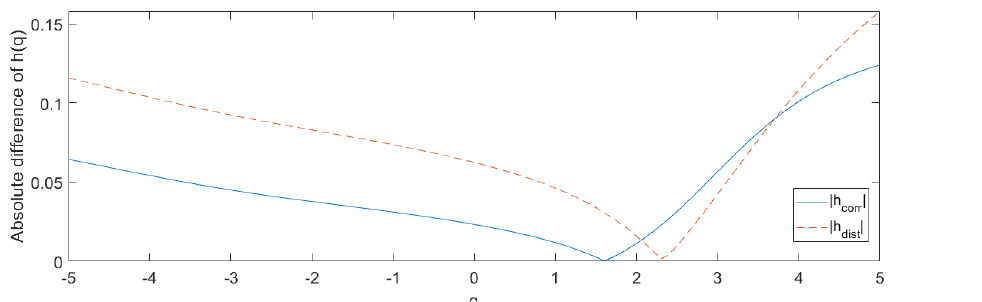
Figure 9. Absolute differences between the generalized Hurst exponents of original and shuffled series, | h corr ( q ) | , and between the generalized Hurst exponents of original and surrogate series, | h ( q ) | , as a function of q dist